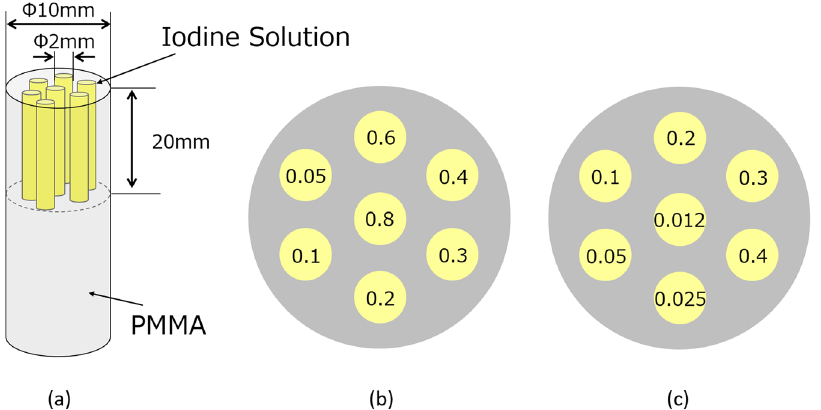
Figure 5. ( a ) Side view of a 10-mm-diameter acrylic cylinder with seven 2-mm-diameter channels filled with I solutions; cross-sections of ( b ) Phantom (I) for verifying the constructed mp-FXCT with concentrations of 0.05, 0.1, 0.2, 0.3, 0.4, 0.6, and 0.8 mg/ml and ( c ) Phantom (II) for evaluating the quantifiability and LOD with concentrations of 0.012, 0.025, 0.05, 0.1, 0.2, 0.3, and 0.4